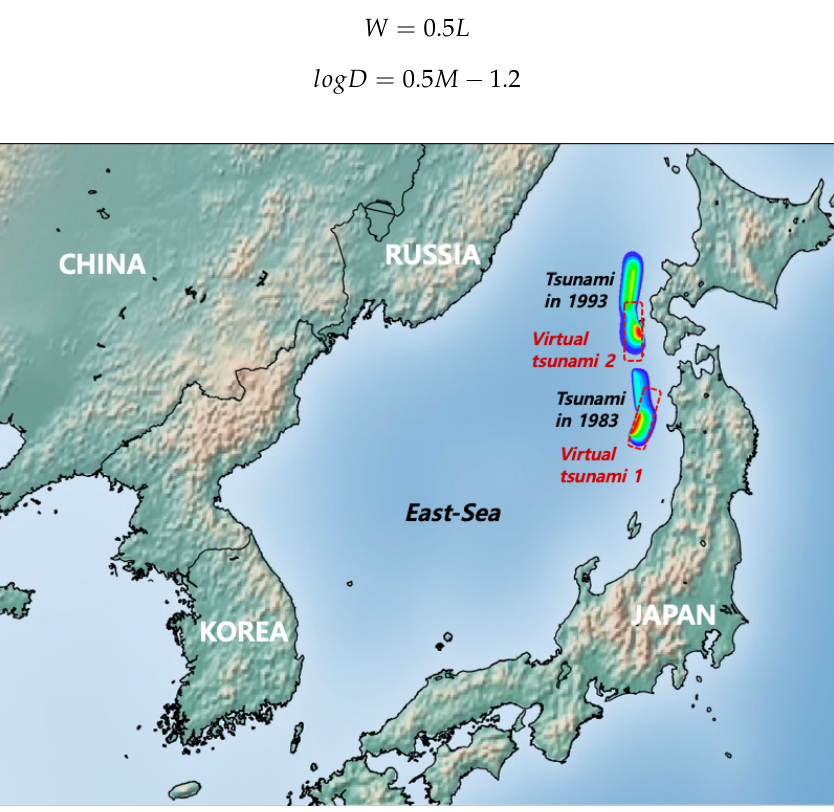
Figure 1. Location of historical tsunamis and virtual tsunamis.